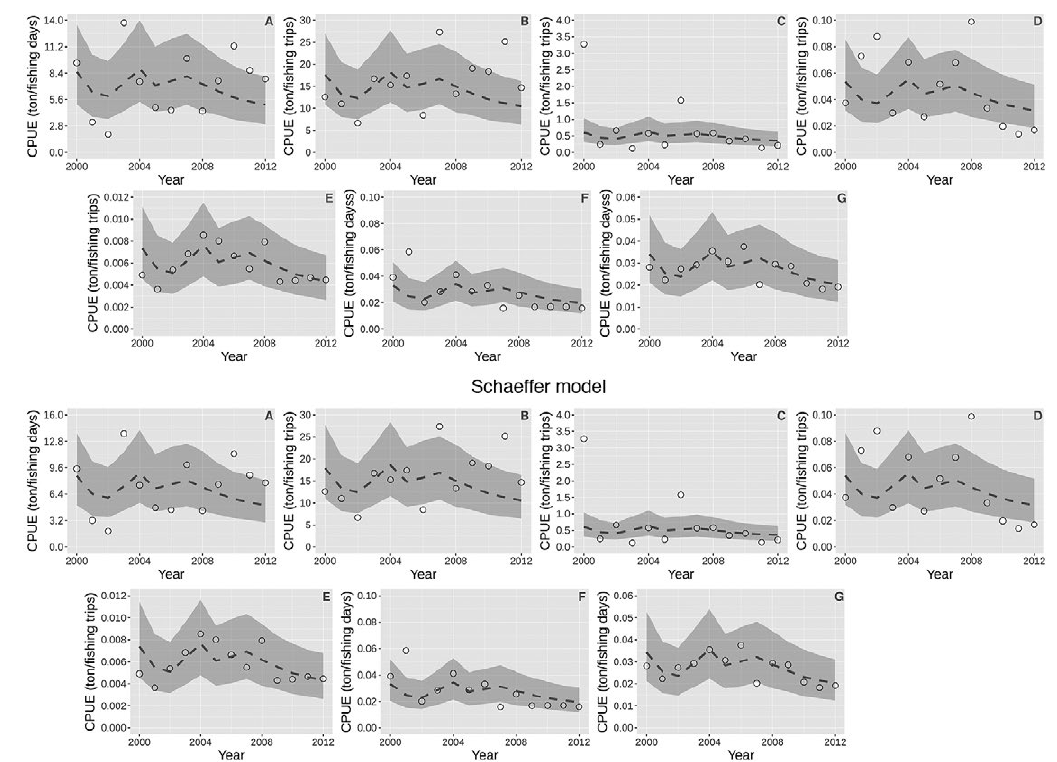
Fig. 5 – Fitted values (dashed line) and 95% credibility region for CPUE of seven fisheries for two Bayesian state-space surplus production models. Top, Pella-Tomlinson model; bottom, Schaeffer model. From left to right: A, industrial purse seine fleet from Santa Catarina State